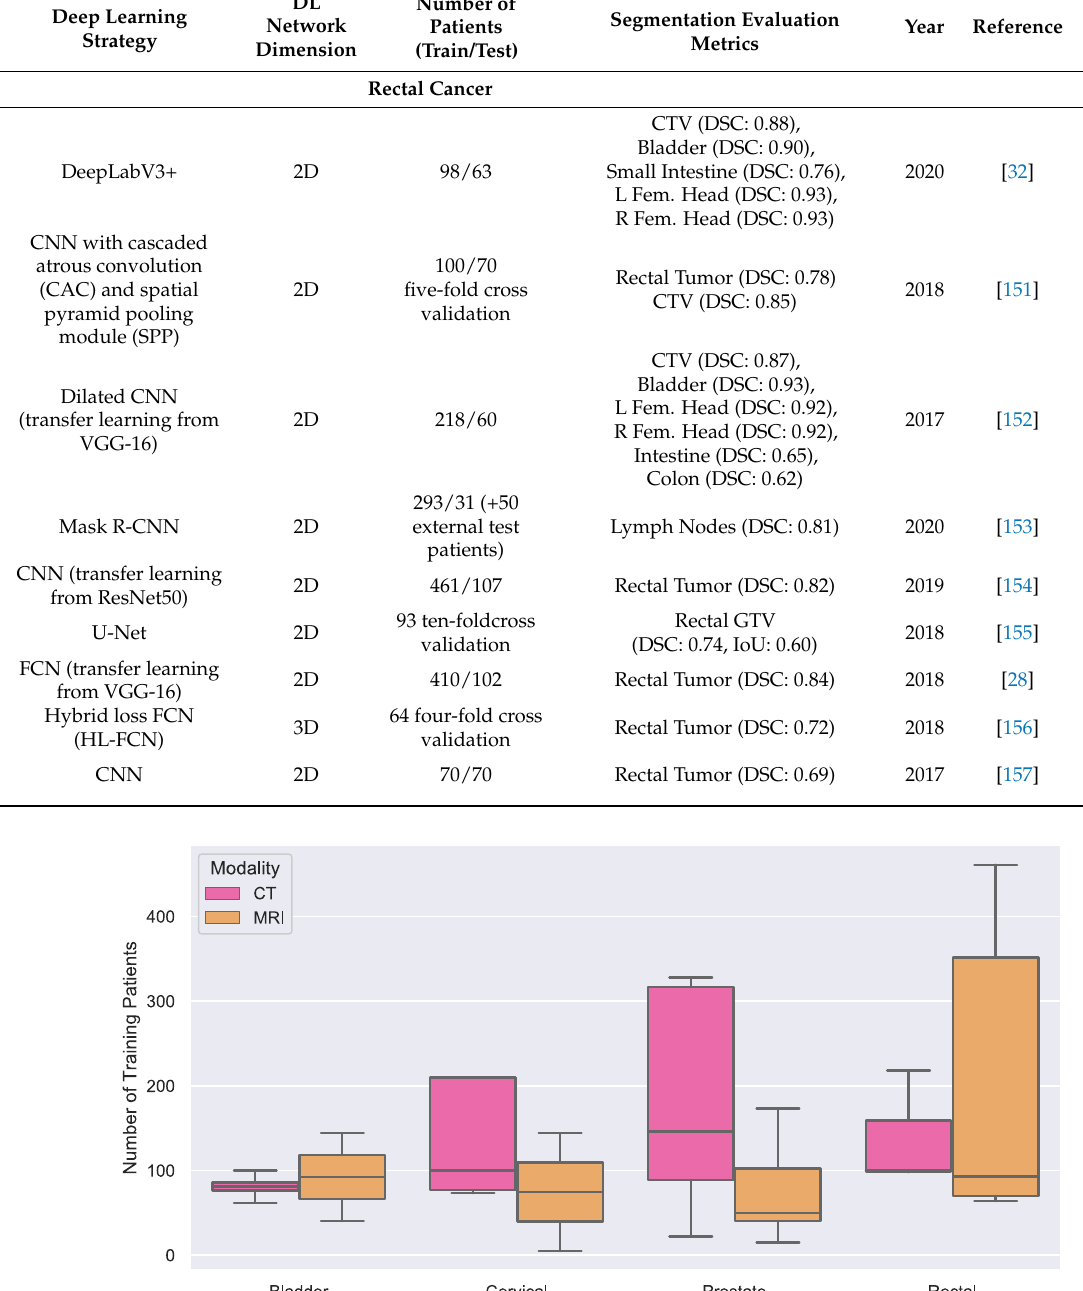
Figure 3. Boxplot of number of training patients used in segmentation applications for bladder (CT